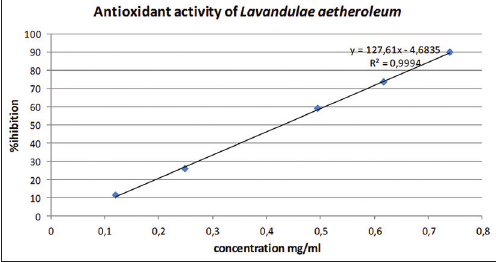
FIGURE 1. Reaction curve between 90 µM 1,1‑Diphenyl‑2‑ picrylhydrazyl and different solutions essential oil of Lavandula angustifolia